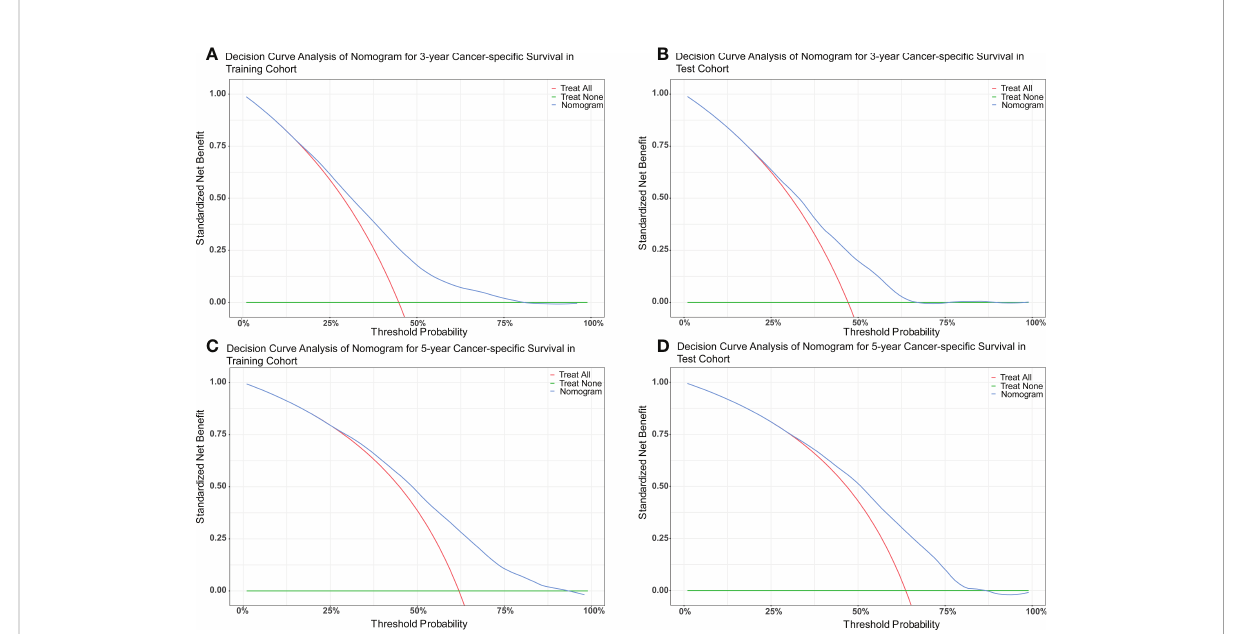
FIGURE 8 (A) DCA of nomogram for 3-year CSS in the training cohort. (B) DCA of nomogram for 3-year CSS in the test cohort. (C) DCA of nomogram for 5-year CSS in the training cohort. (D) DCA of nomogram for 5-year CSS in the test cohort.